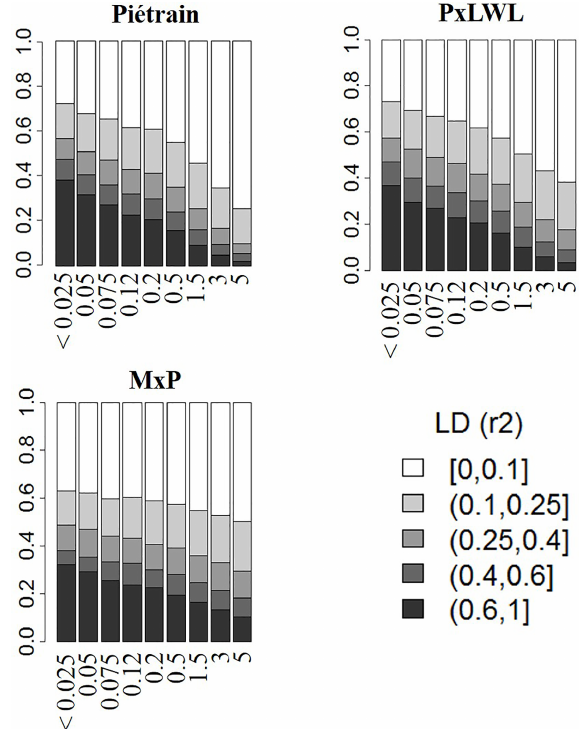
Figure 1. Linkage disequilibrium decay as a function of the marker distance in a purebred Piétrain population and in F2 crosses derived from closely (Piétrain × Landrace/Large White) and distantly (Pié- train × Meishan) related founder breeds (Sus scrofa chromosome